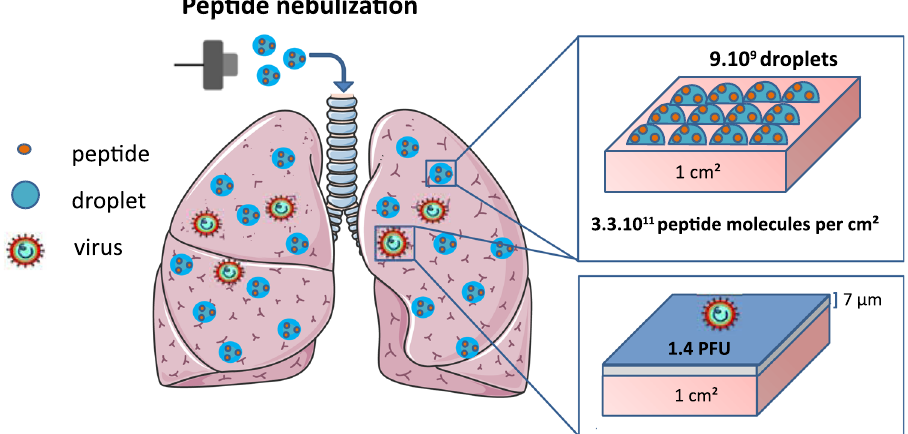
Fig.5|Schematicpresentationofthepeptideandvirusdepositioninthelungs. The calculation based on the estimation of the peptide dose per unit of lung internal surface, taking into consideration the number of droplets formed follow- ing the administration and the peptide molecules into the pulmonary area. Fol- lowingthe nebulization,11% of theformeddropletsreachedthelungs(asshownin Fig. 3a), representing a density of 9×10 9 droplets/cm 2 of lung internal surface and